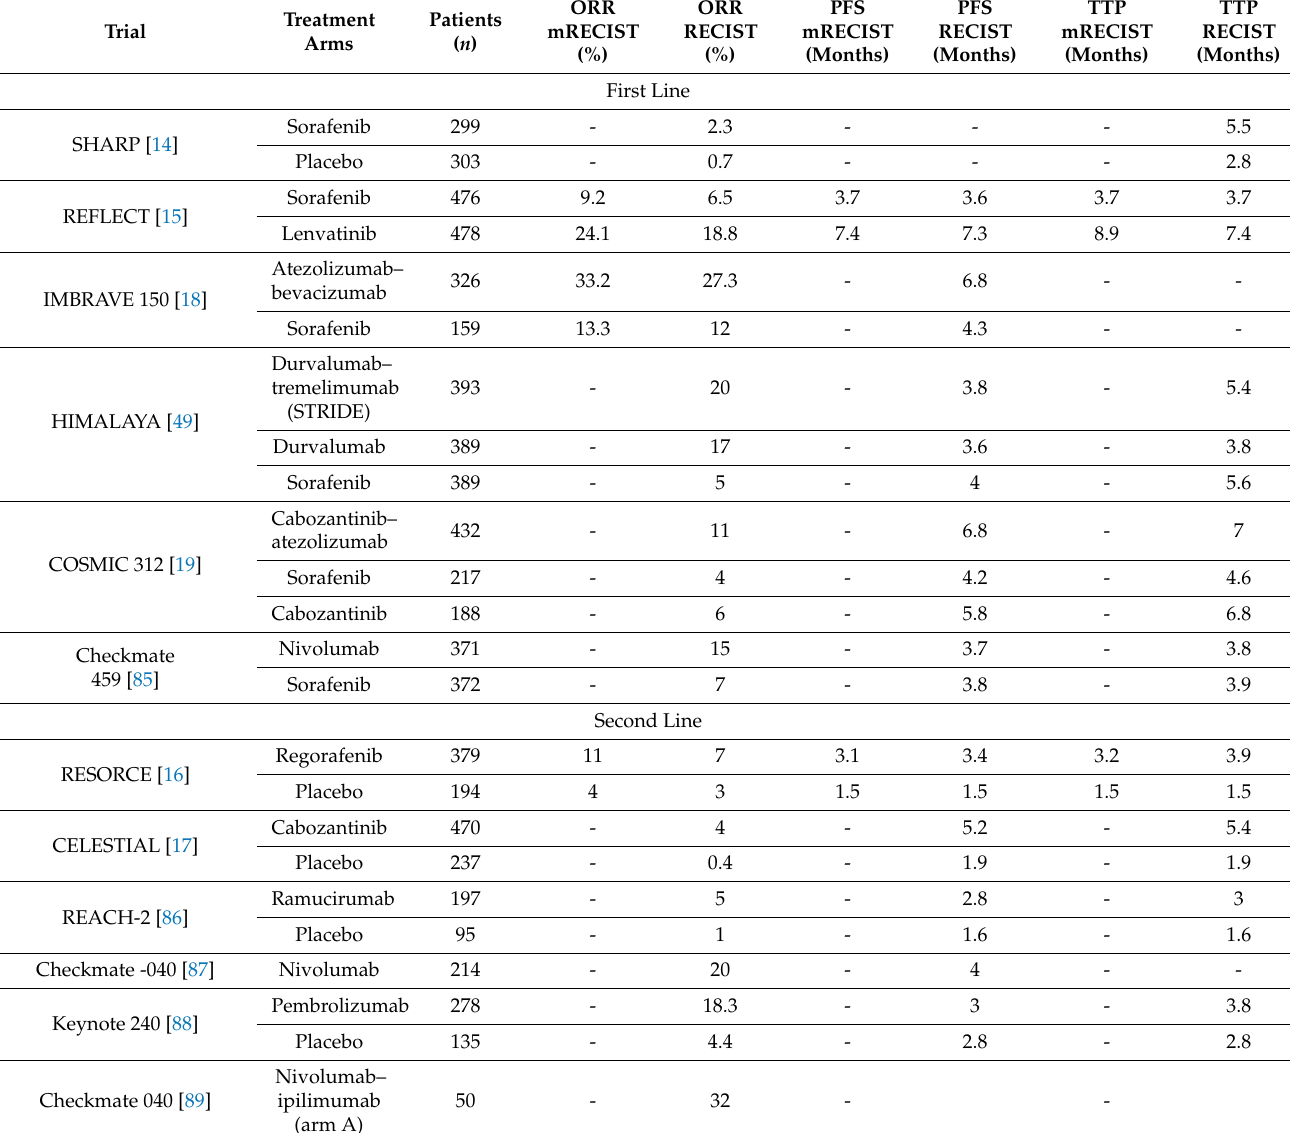
Table 3. Radiological endpoint assessment in RCTs of systemic treatment for unresectable